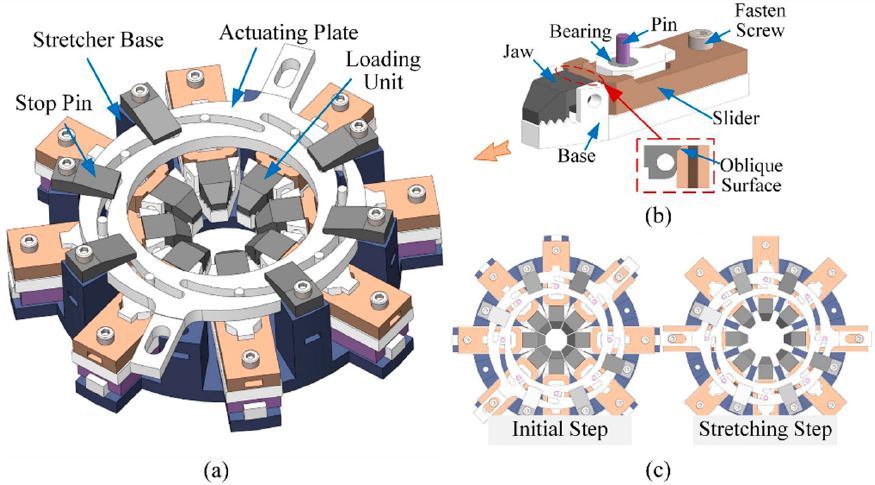
Figure 1. Schematic representation of the stretcher’s mechanical structure: ( a ) whole stretcher; ( b ) loading unit; ( c ) top view of stretched and unstretched positions.